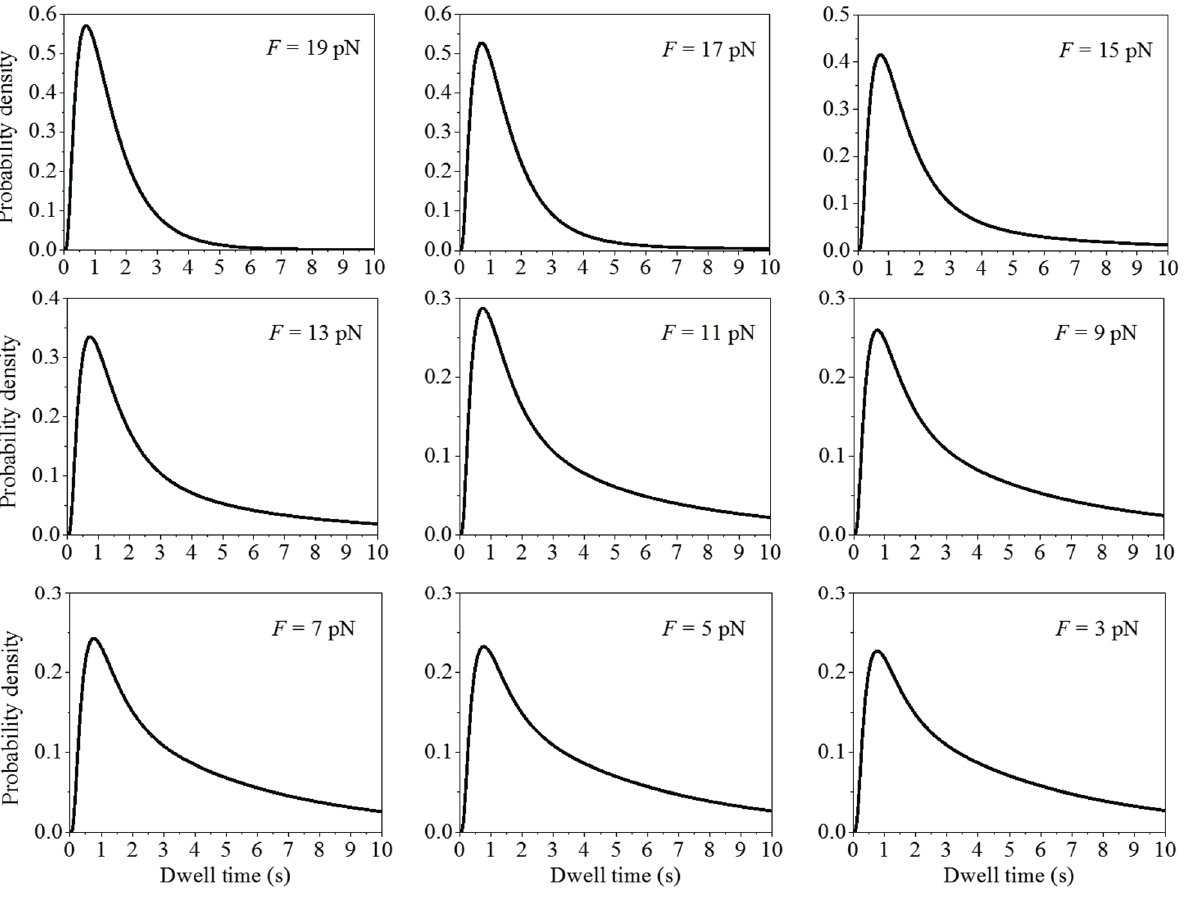
Figure 3. Normalized distributions of dwell times, h ( t ), calculated with different values of F , where E bp = 3.2 k B T